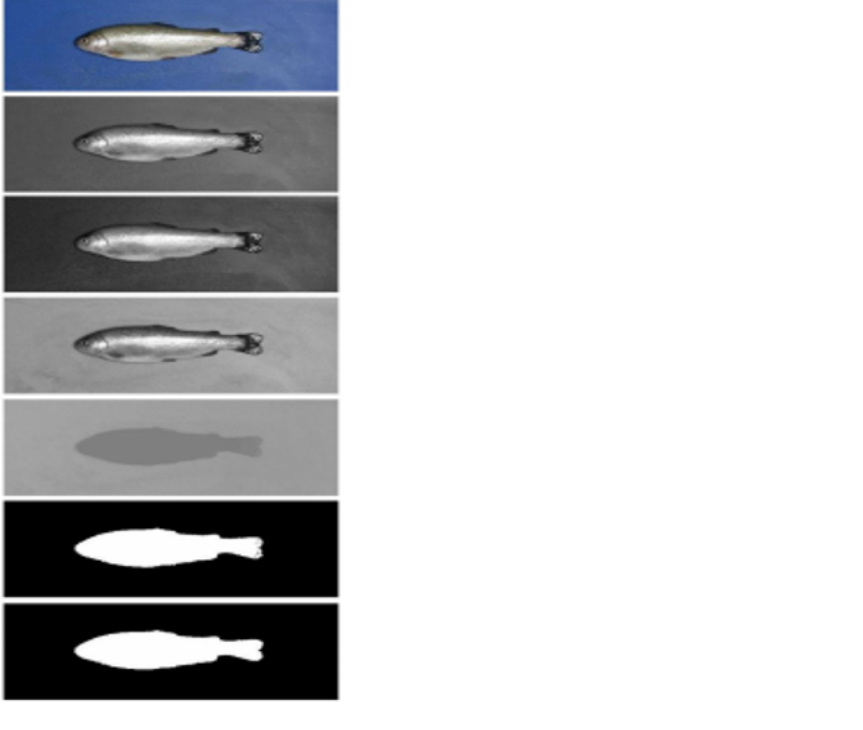
Figure 14. Sort by: original form, R, G, and B color model, one color channel median filter, Cb image component, Grayscale image, Noise